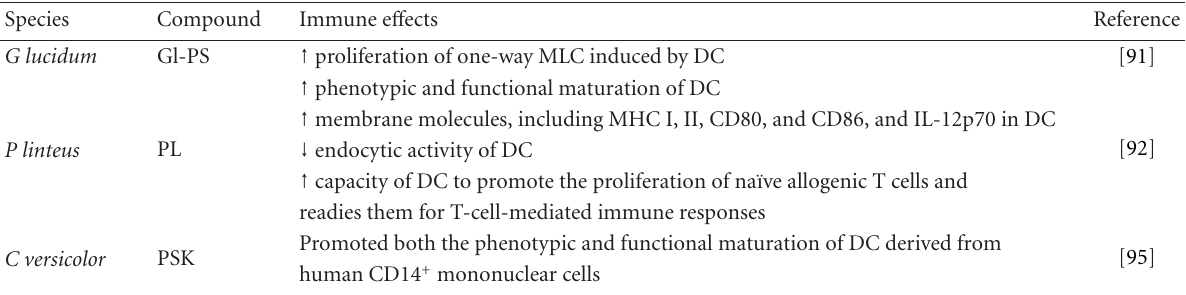
Table 4. Immunomodulatory activities of mushroom compounds on DCs.